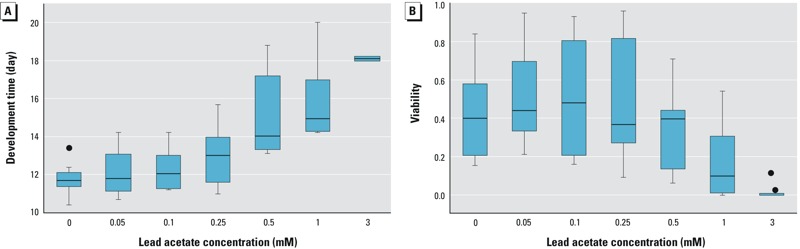
Box plots representing dose–response relationships for flies grown on lead acetate supplemented media for development time (A) and viability (B) across 10 randomly selected DGRP lines (DGRP_21; DGRP_208; DGRP_304; DGRP_313; DGRP_324; DGRP_335; DGRP_362; DGRP_517; DGRP_732; DGRP_852). Boxes extend from the 25th to the 75th percentile, horizontal bars represent the median, whiskers extend 1.5 times the length of the interquartile range (IQR) above and below the 75th and 25th percentiles, respectively, and outliers are represented as black circles.